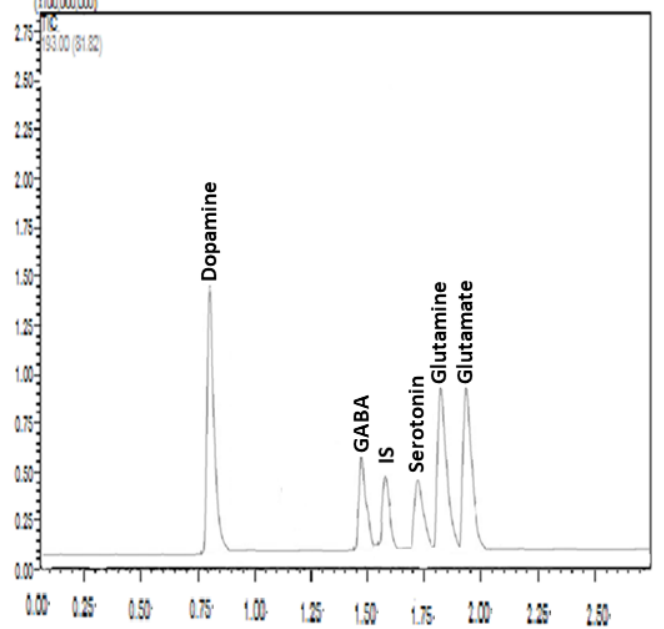
Figure 3. A representative chromatogram under optimized conditions: Zorbax SB C18 column (3.0 × 100 mm, 1.8 µ m particle size); mobile phase, 0.3% heptafluorobutyric acid (HFBA) and 0.5% formic acid solution–acetonitrile with gradient elution; flow rate, 0.3 mL/min; and injection volume, 5 μL. The analytes of interest are shown above each peak. IS: Internal standard (epinephrine), X axes (retention time in minutes), Y axes (relative intensity).